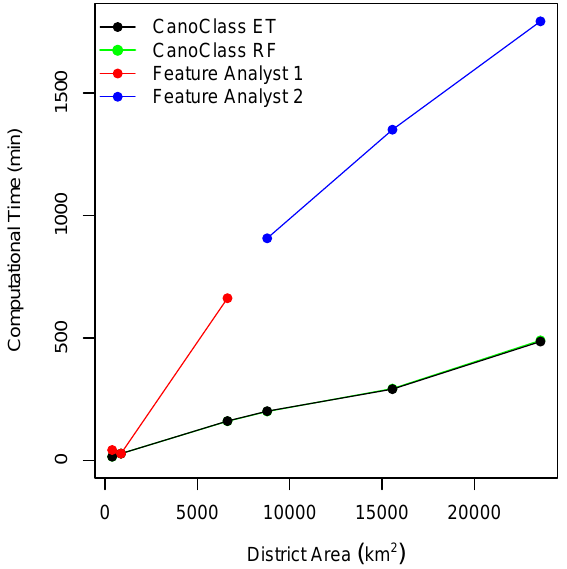
Figure 4. Computational times versus district areas.